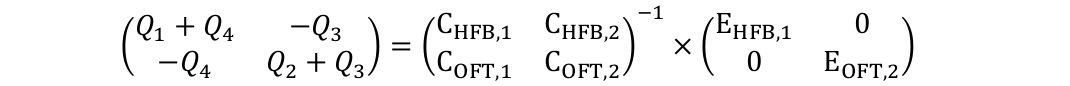
to Q (m 3 ·h − 1 ); concentrations C 1 6 and E (mg·h − 1 ); particle penetration factors k 1 2 and k (h − 1 ); and capture efficiency of filters D,1 D,2